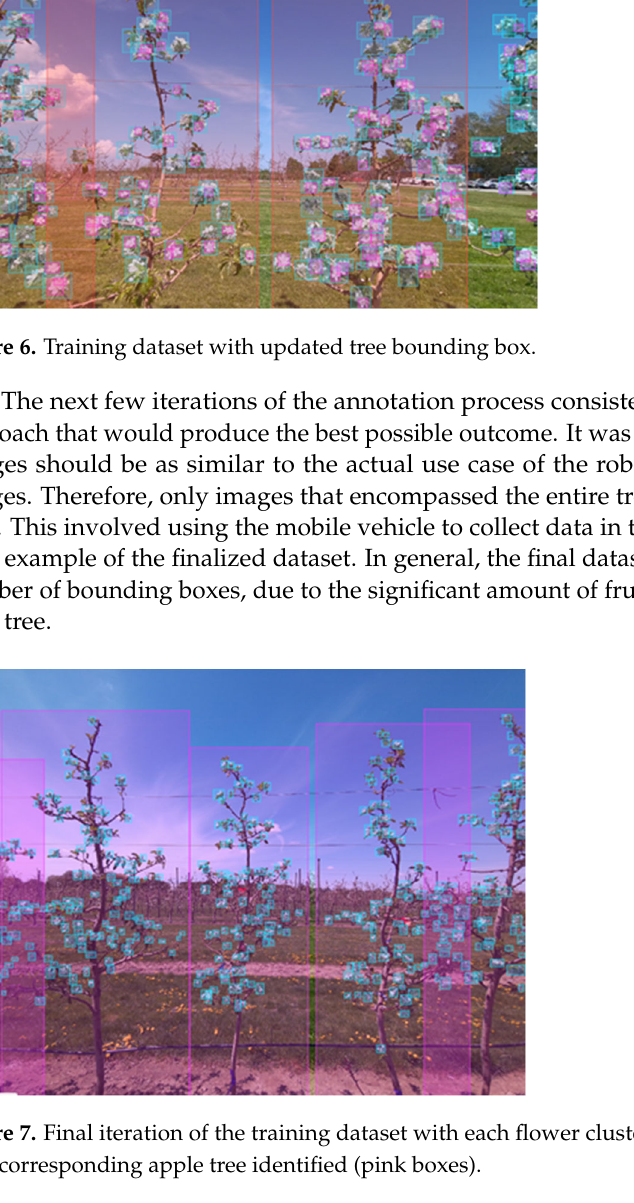
Figure 5. Training dataset in its first iteration.